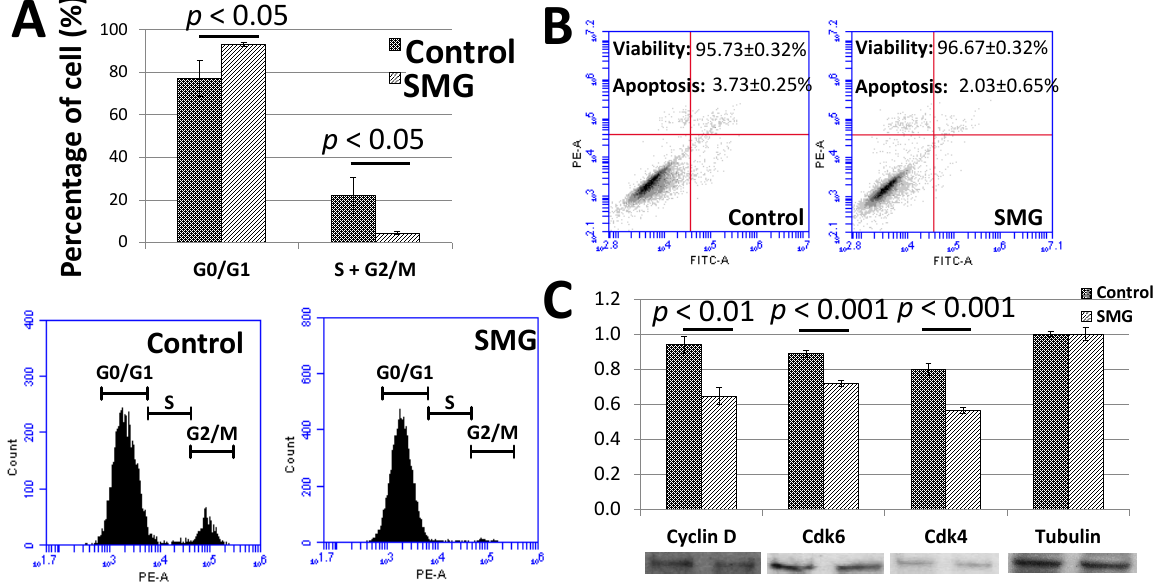
Figure 2. Cell cycle progression of pGCs. ( A ) Cell cycle analysis of pGCs evaluated by flow cytometry; ( B ) the viability of pGCs was assessed by flow cytometry; ( C ) the expression of major cell cycle-related proteins was estimated by Western blot. The present study also evaluated the expression of major cell cycle-related